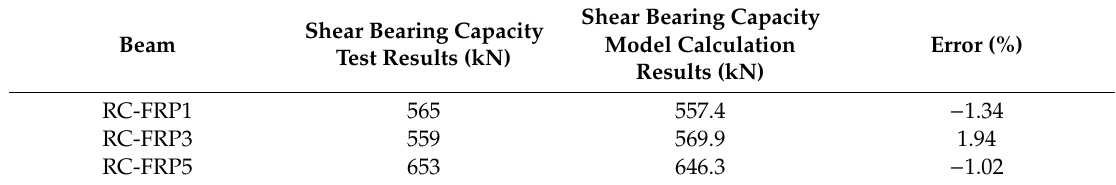
Table 11. Calculation results of shear capacity model for the RC beam strengthened by flax fiber sheets.